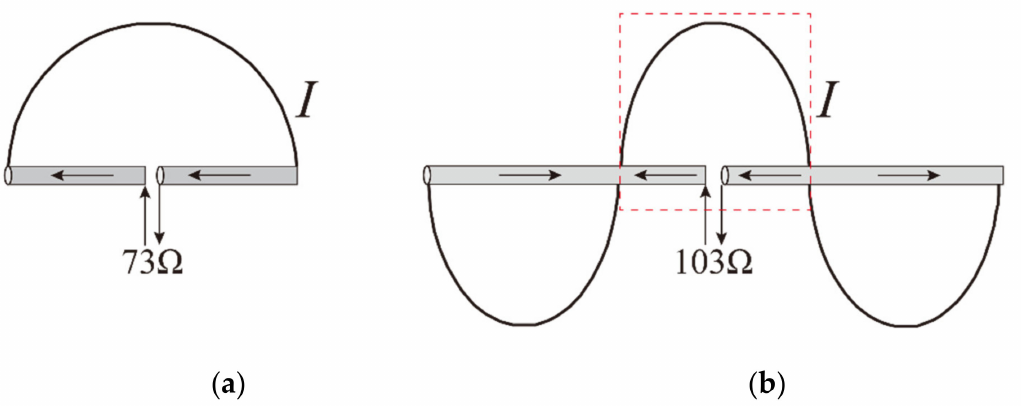
Figure 2. The current distribution of dipole with different lengths: ( a ) 0.5 λ dipole; ( b ) 1.5 λ